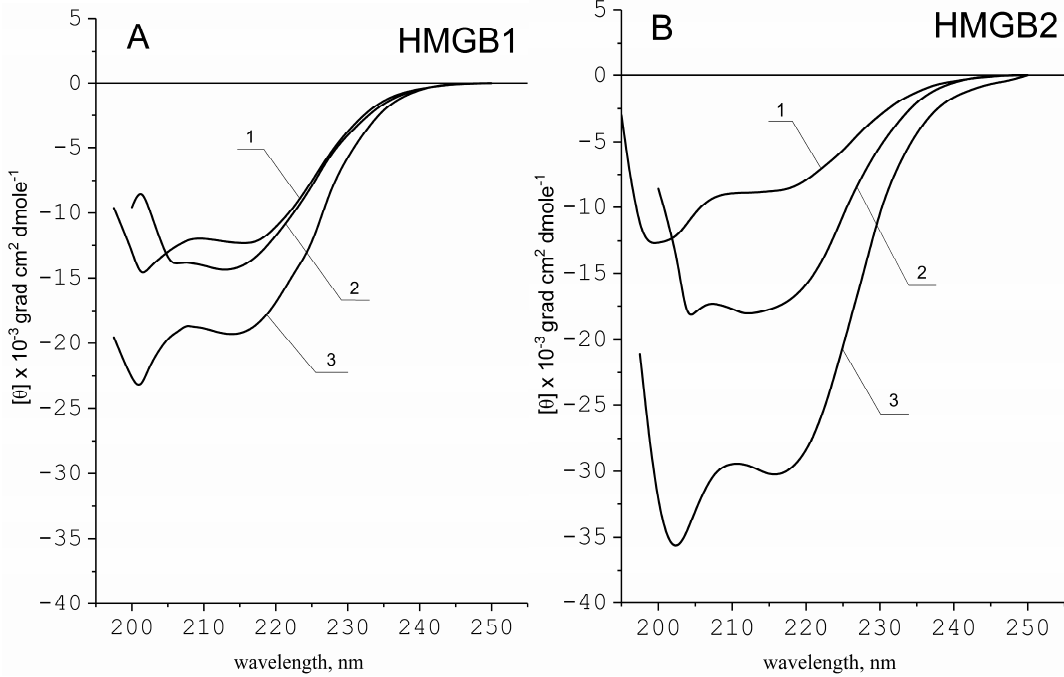
Figure 2. CD spectra of HMGB1 ( panel A ) and HMGB2 ( panel B ) proteins. Circular dichroism (CD) spectra of HMGB1 and HMGB2 are presented the Figure. The obtained CD spectra are presented in terms of molar ellipticity [ θ ]. The spectra are obtained in an aqueous solution (curve 1), 80% ethanol (curve 2), and 1.5 M NaCl (curve 3). The spectra are obtained in an aqueous solution (pH 6.0), 80% ethanol, and 1.5 M NaCl. Estimation of α -helicity (see Discussion) showing that in neutral solvent, HMGB1 forms ~25% of α -helices, while HMGB2 only ~15%. HMGB2 is characterized by a greater ability to form α -helices in 80% alcohol and 1.5 M NaCl. The degree of α -helicity of the proteins in 80% alcohol solution is 30% and 40% for HMGB1 and HMGB2, respectively; in solution of 1.5 M NaCl the α -helicity is ~40% and ~70%, respectively.